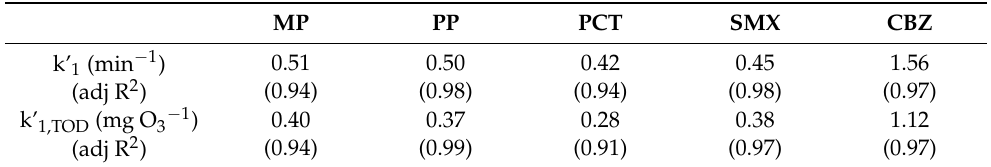
Table 1. Pseudo-first order kinetic rate constants of ozone-treated contaminants in ultrapure water (pH 5.5), individually, as a function of time (k’ 1 ) and as a function of TOD (k’ 1,TOD ). The initial concentration of each contaminant (MP, PP, PCT, SMX and CBZ) was 1 mg L − 1 . The corresponding adjusted coefficients of determination (adj R 2 ) are also presented. MP PP